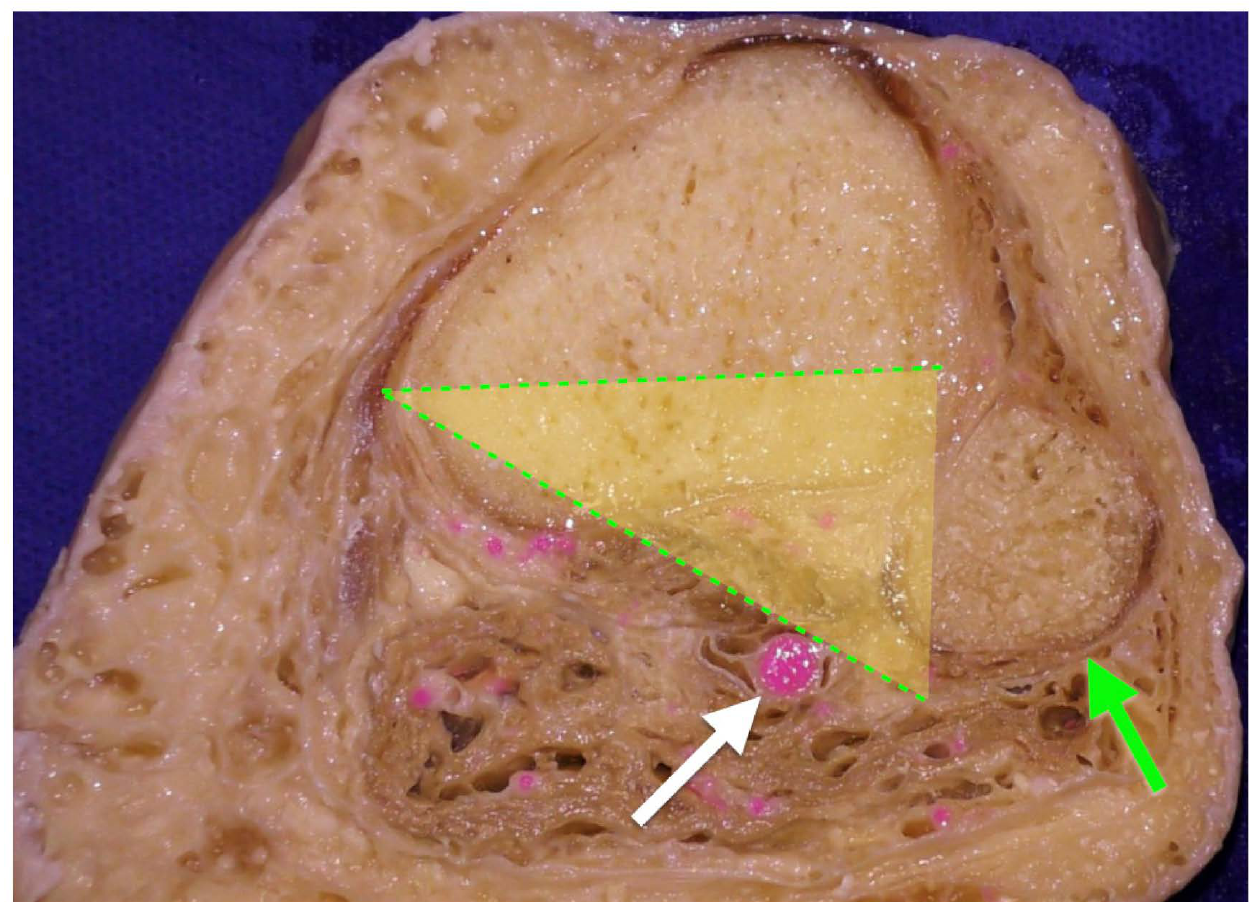
Figure 5. Axial cut of the right tibia approximately at 3 cm below the joint line. The yellow triangle represents a safe zone during medial open wedge high tibial osteotomy in the axial plane in order to avoid popliteal artery damage. Safe angle values in the axial plane for medial open wedge high tibial osteotomy were calculated to be 38.9 ◦ ± 6.5 ◦ (yellow triangle) by Choi et al. [5], assuming that the anterior portion of the safe angle is parallel to the coronal plane and starting at the most medial edge of the tibia (there was no significant difference in these values between flexion and extension). One should keep in mind the inclination of the osteotomy plane (from the medial side of the tibia 3–3.5 cm below the joint line and aiming upwards and towards the fibula head). White arrow: popliteal artery. Green arrow: head of